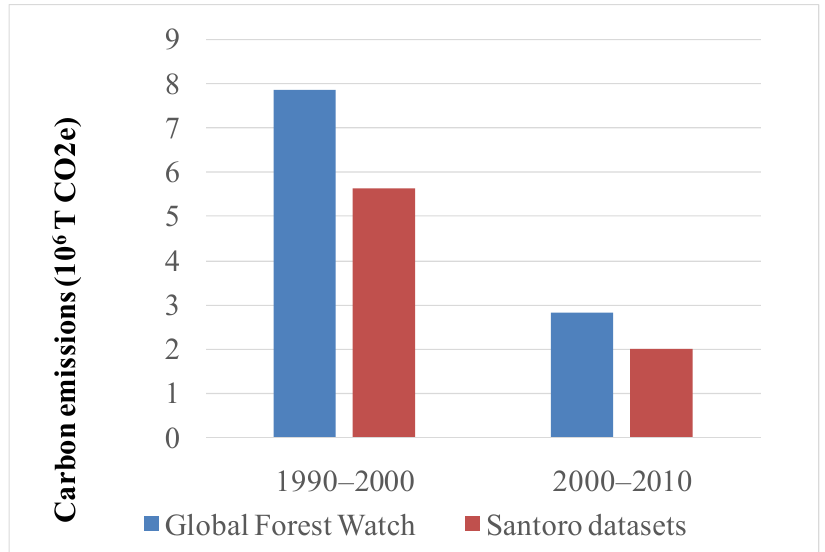
Figure 5. Carbon emissions for the period 1990–2000 and the period 2000–2010.